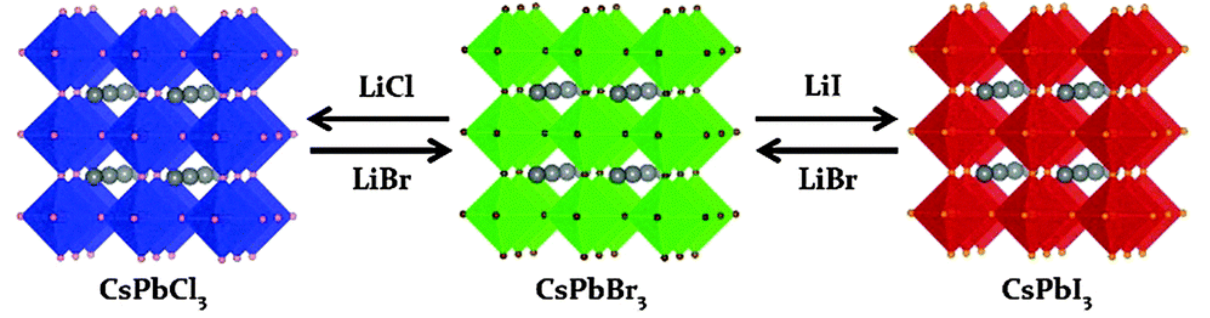
Figure 11. Schematic of substituting anion in CsPbX 3 NCs [6]. Copyright 2016 Royal Society of Chemistry.